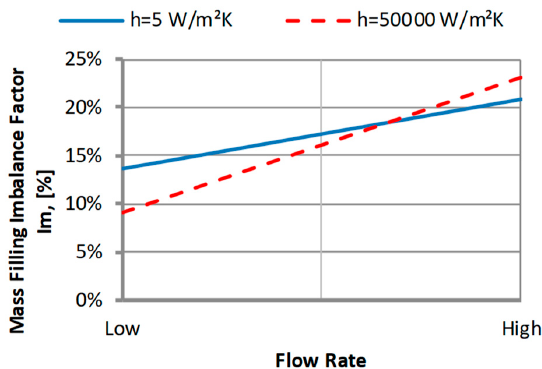
Figure 19. An effect of the heat transfer coefficient h on the mass filling imbalance factor I m at various injection rates (Low = 5 cm 3 /s, High = 500 cm 3 /s).